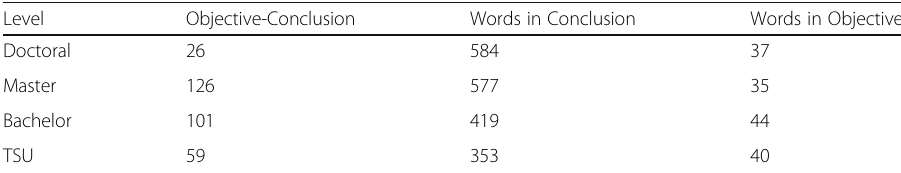
Table 1 Text Corpus (words in